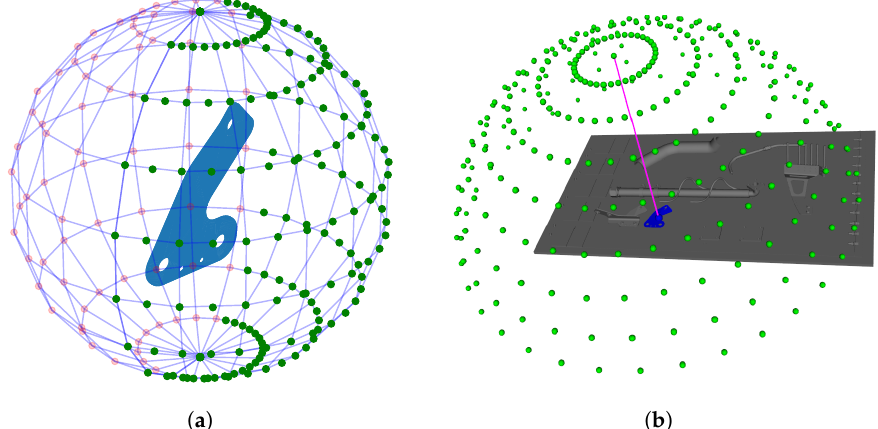
Figure 20. The candidate viewpoint region is defined as a part of sphere surface. The accessible viewpoints in green and the inaccessible viewpoints, due to occlusions related to the global CAD, in red ( a ) for a given element to be inspected and ( b ) for the whole assembly.